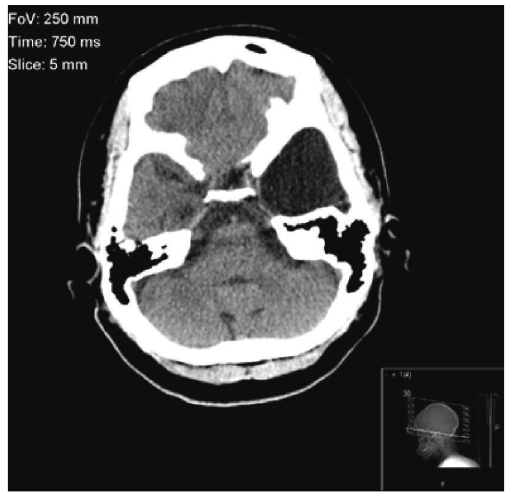
Figure1:CranialCTwithoutcontrastinthehorizontalplane,show- ing an arachnoid cyst in the region of the left temporal lobe.